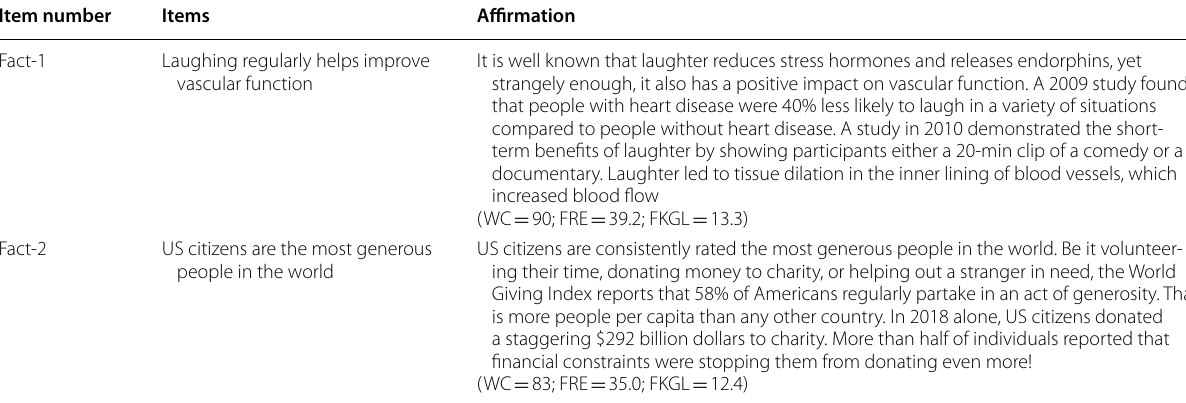
Table 10 Facts and their Corresponding Affirmation